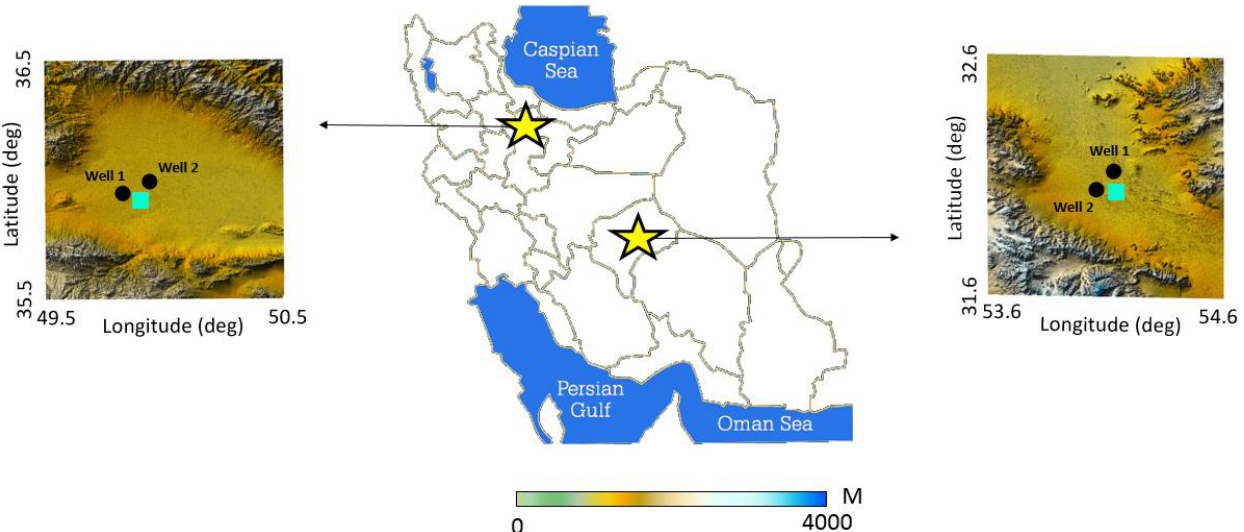
Figure 4. The geographical location of the study areas. The squares show the position of synoptic and GPS stations and the circles represent the location of groundwater well observations.